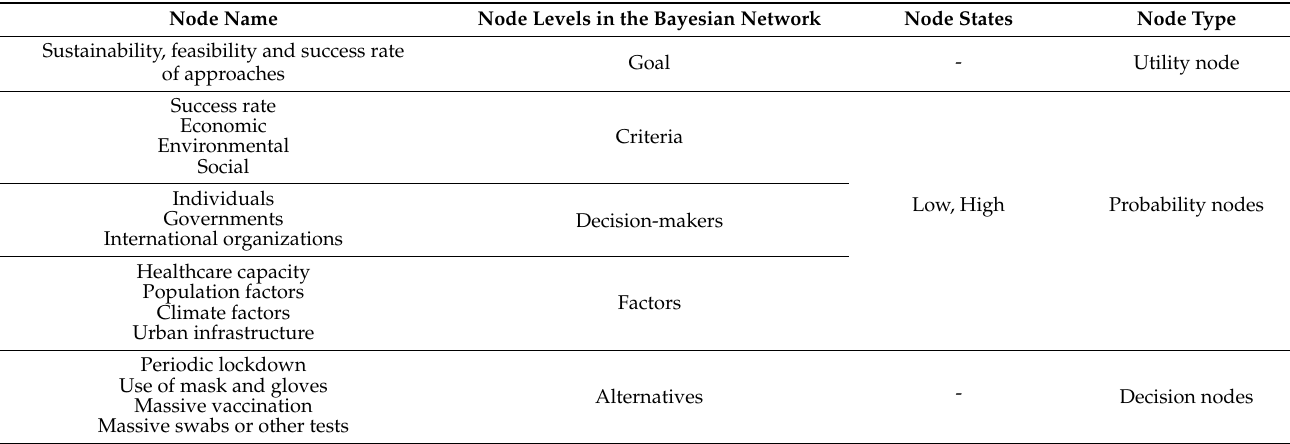
Table 13. The structure and descriptions of nodes in the developed